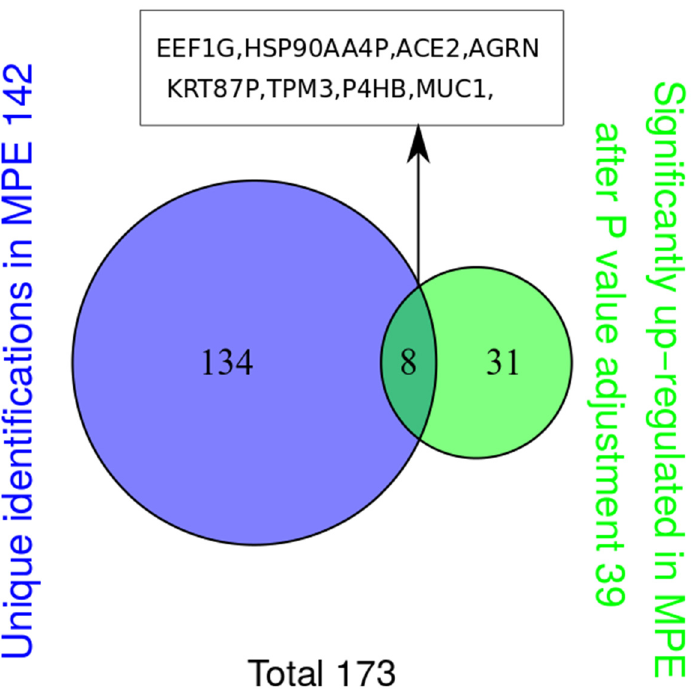
Figure A5. Comparison of proteins identified only in MPE samples with proteins observed as significantly up-regulated after p -value adjustment for multiple testing.